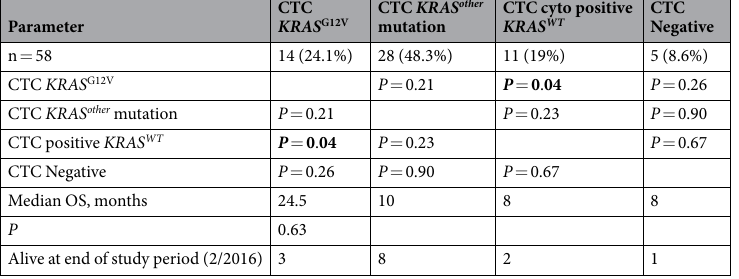
Table 2. Pairwise comparison of KRAS mutations and overall survival in PDAC patients.